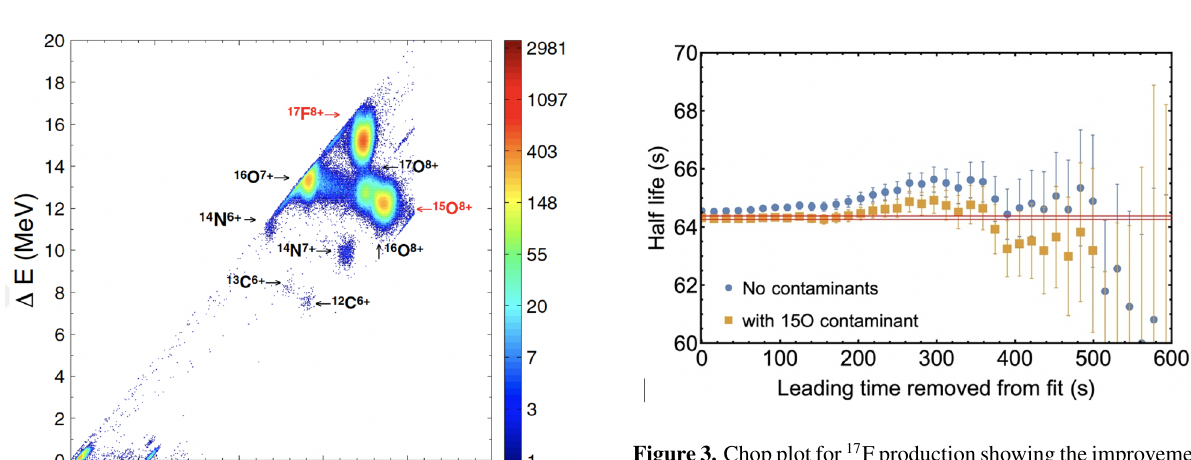
Figure 3. Chop plot for 17 F production showing the improvement obtained by including a 0.2% contamination of 15 O.